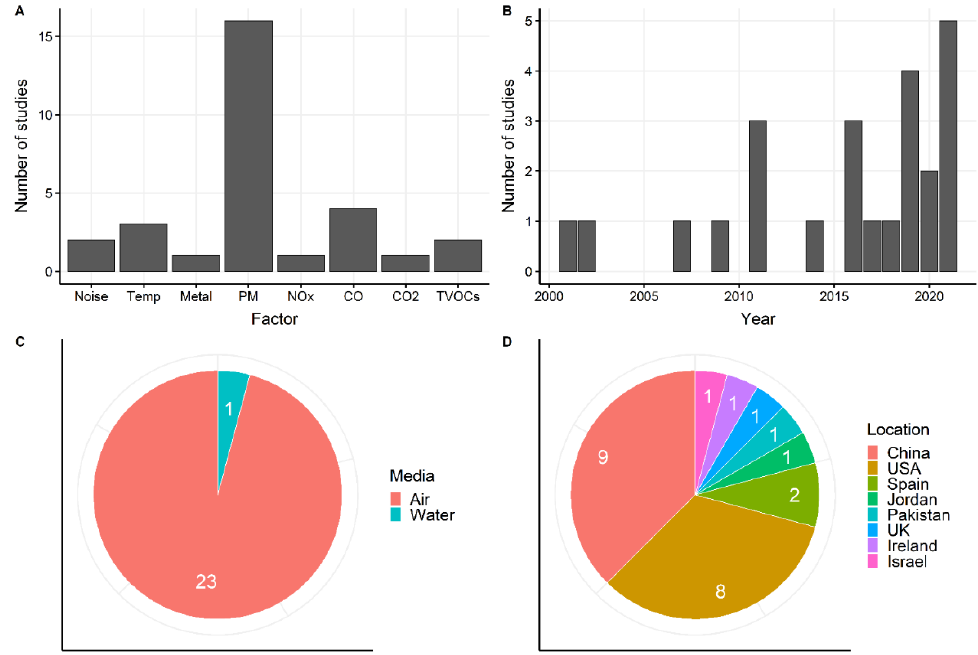
Figure 2. Summary of the included studies by: ( A ) environmental factors, ( B ) published year, ( C ) environmental media, and ( D ) location of field tests. Abbreviations: Temp = temperature; PM = particulate matter.